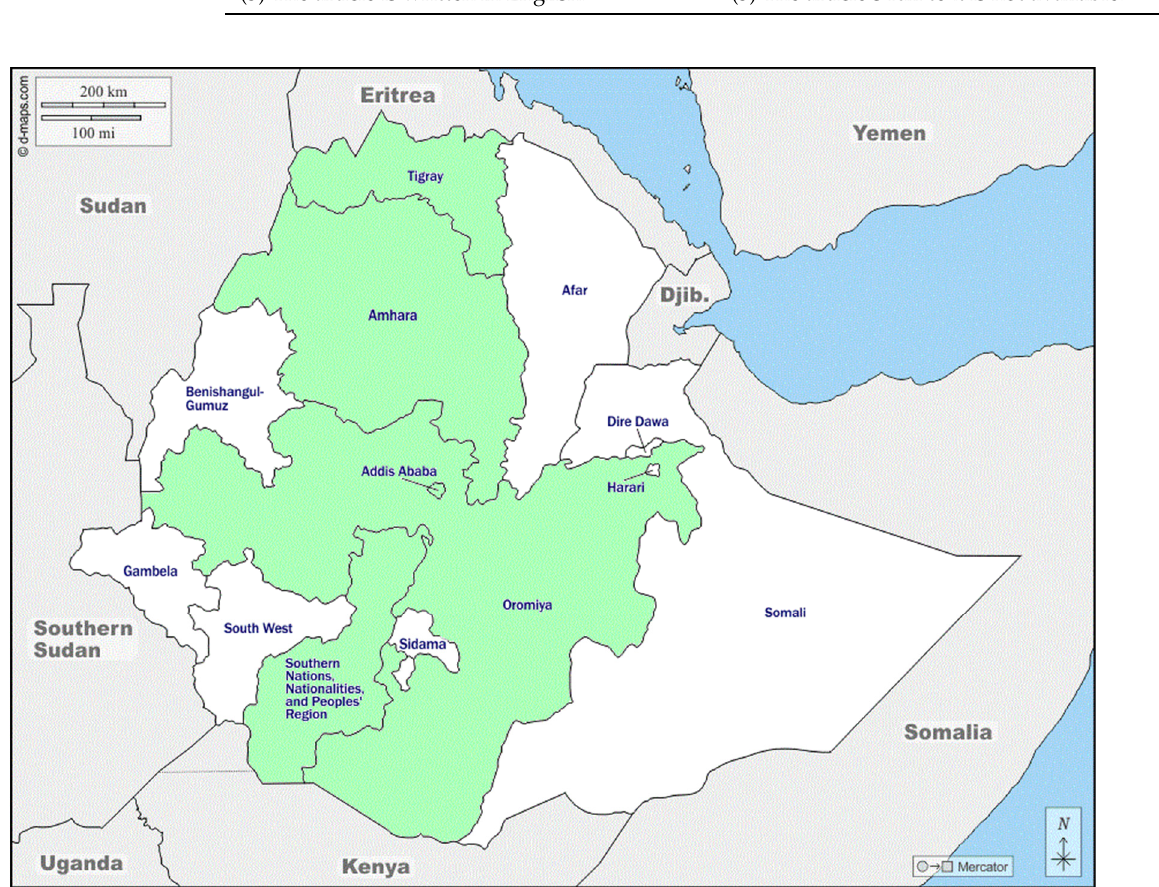
Figure 1. Map of the locations of the